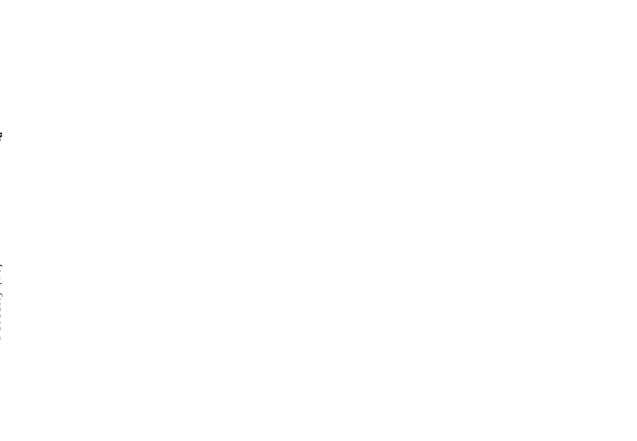
Figure 2. Effect of different sintering time at 1380 °C on microwave dielectric properties of 0.774Ba(Zn 1/3 Nb 2/3 )O 3 -0.226BaSnO 3 ; data from Ref.